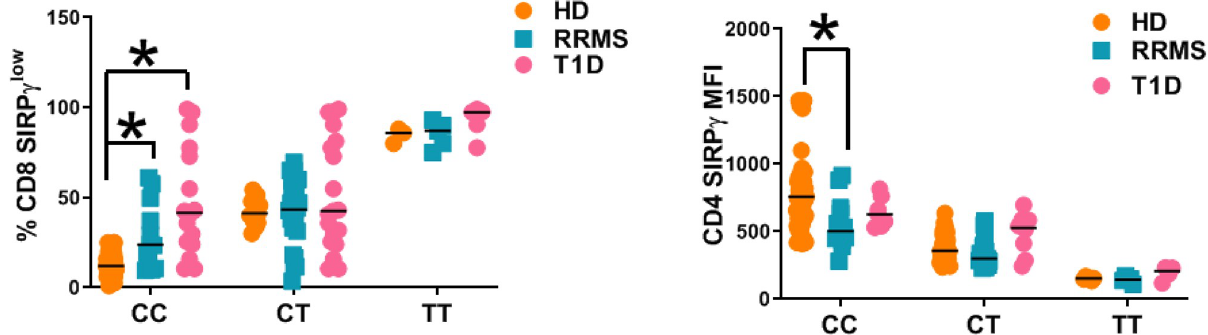
Fig 3. SIRP γ expression is regulated outside of rs2281808 genotype in autoimmunity. PBMC samples from HD, RRMS and T1D patients were subjected to flow cytometry staining to detect SIRP γ on gated CD3, CD4 and CD8 T-cells. SIRP γ expression on T-cells was compared between the rs2281808 genotypes in the study populations. SIRP γ gMFI data for CD4 T-cells and frequency of SIRP γ low CD8 T-cells are shown. Two-way ANOVA with Tukey’s multiple comparison was performed and p < 0.05 was considered significant.